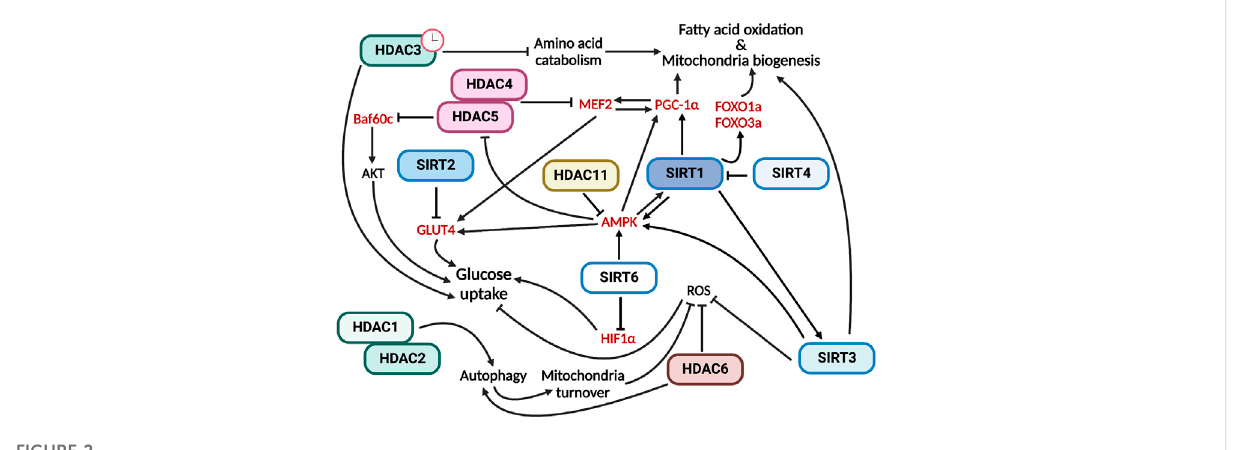
FIGURE 2 HDACs have multiple and speci fi c functions in regulating skeletal muscle metabolism. In red are indicated the HDAC direct